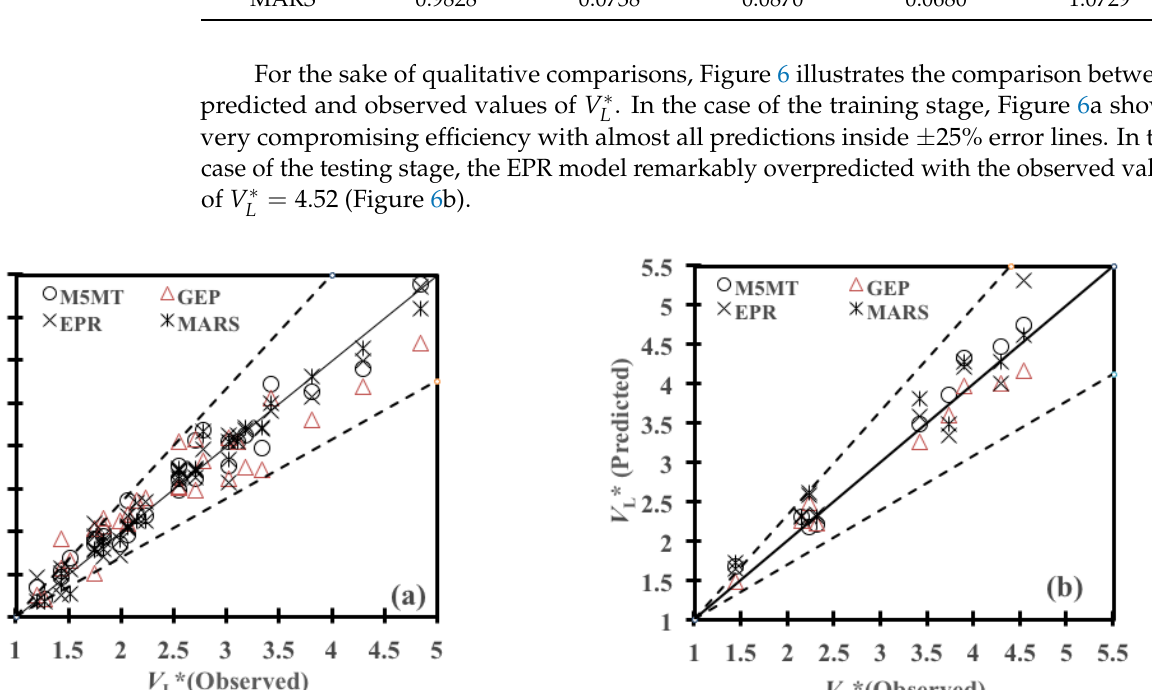
Table 3. Statistical performances of the AI models in the estimation of V ∗